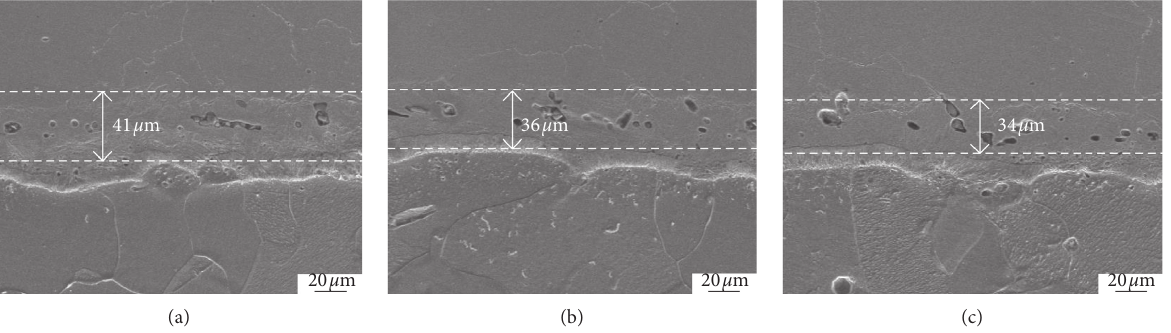
Figure 10: SEM morphology of the bonding layer with 50% reduction rate (500x). (a) Area I. (b) Area II. (c) Area III.